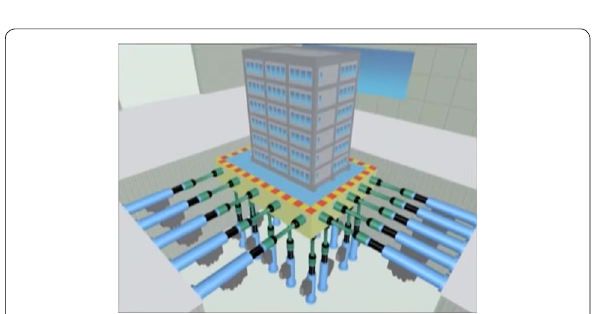
Figure 9 E-DEFENSE seismic simulation testing